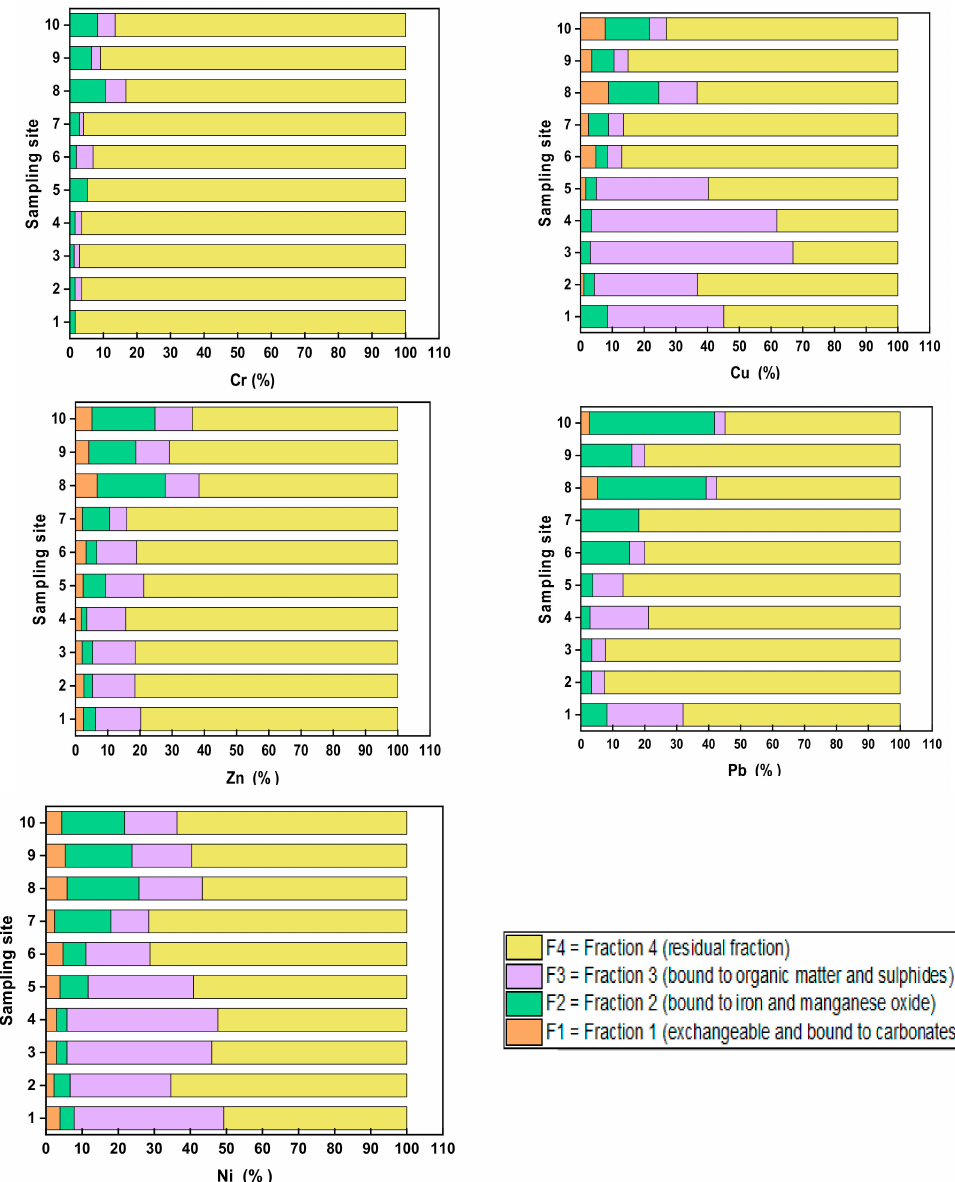
Figure 2. Stacked plot of concentration (%) of di ff erent fractions of Cr, Cu, Zn, Pb and Ni. The fractionation profile of Copper indicated that Cu is relatively often bound with fraction 3 at sites S1–S5 and with residual fraction at sites S6-S10. A similar pattern of spatial variation is also reported in Mahanadi River in India by Nemati et al. [7]. In general, Copper is readily influenced by organic complexation due to the strong interaction between the metal and dissolved organic matter [36]. In addition, being strongly chalcophile Cu in mineral form occurs mostly in sulfides. Copper tends to exist with organic and residual fractions, which was also observed in the Yamuna River in India [37]. Copper bound with Iron and Manganese oxides fraction F2 was observed at all sites with the highest portion at S8 and S10. Iron and Manganese oxides can exist as a coating on the particles, as nodules, cement between particles and Cu likely binds the nodules with these oxides. Likewise, the exchangeable fraction was observed at S2 and S5 to S10 with maximum concentration at S8 and S10. The Copper bound with fraction 1 and fraction 2 with the highest concentrations at S8 and S10 indicated an additional anthropogenic